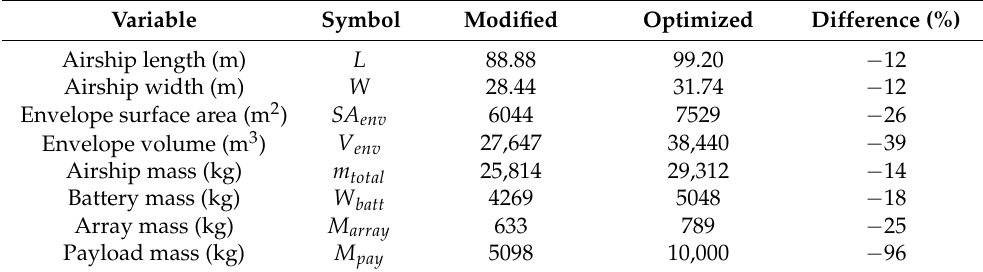
Table 3. Optimal outcome of the multi-lobed airship with conventional (baseline) and hybrid propulsion technology to carry 10,000 kg of payload.